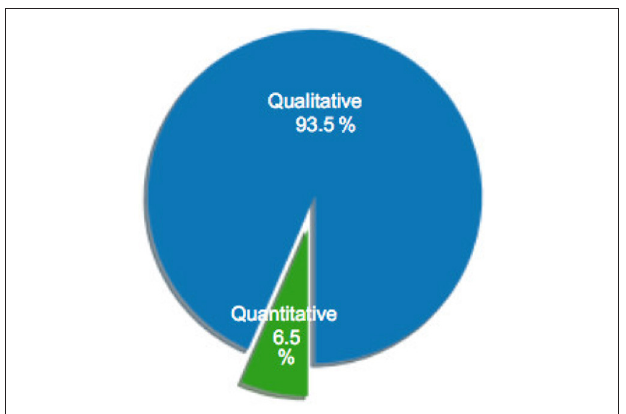
FIGURE 4 | Percentage of sample articles by research objective.